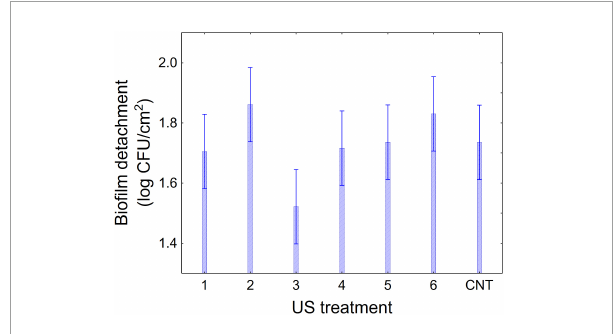
FIGURE1 Decomposition of statistical hypothesis related to the individual term of US-treatment on the detachment of biofilm (log CFU/cm 2 ) of L. plantarum c19 and DSM 1055. Mean values ± 95% confidence interval.